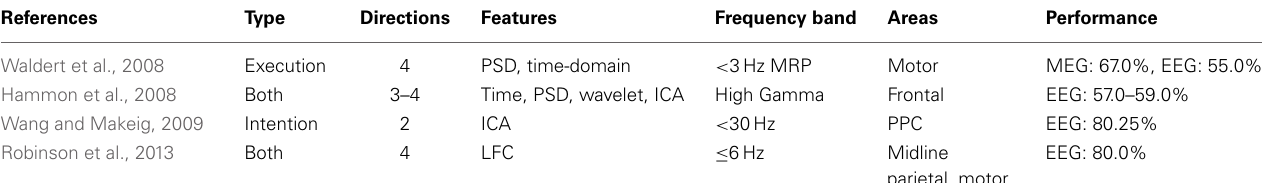
Table 4 | Non-invasive methods used for decoding movement